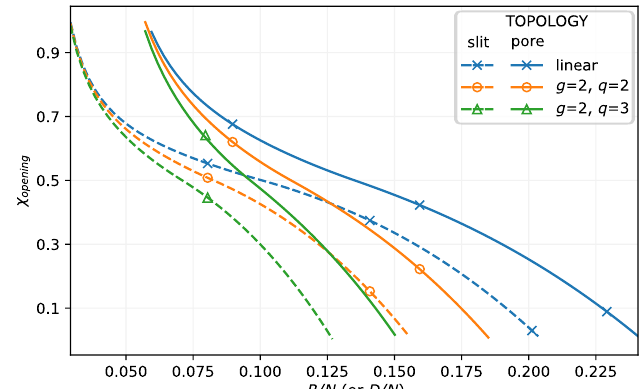
Figure 4. χ opening for the pore (solid lines) or a slit (dashed lines) with grafted linear, or dendron brush g = 2, q = 2, or q = 3 with N = 1000, σ = 0.02 as a function of the pore radius R or the slit thickness D (see Figure 1) normalised by N . Topologies are indicated with markers, where cross, circle, and square markers are linear chains and dendroids of the second generation, g = 2 of different functionalities q = 2 and q = 3,